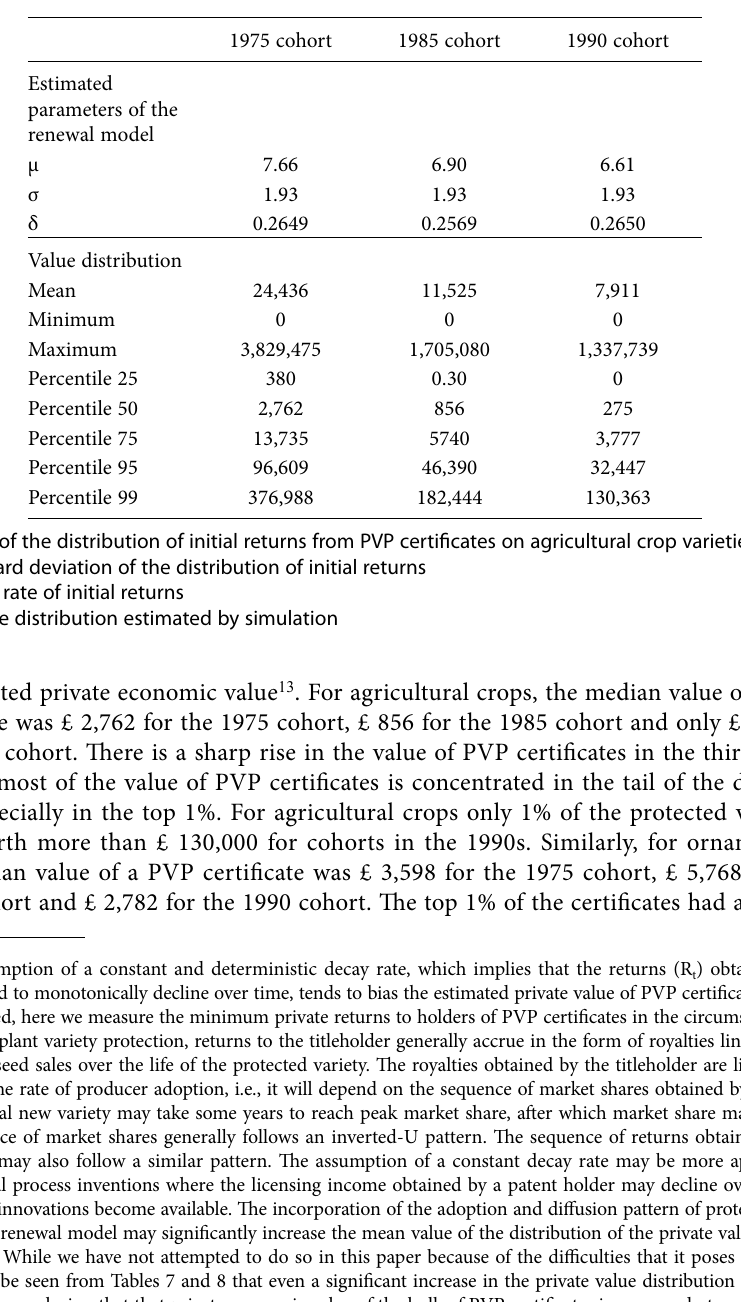
Table 7. Estimates of the private value distribution of PVP certificates for agricultural crops in the UK (all values in constant 2003 UK